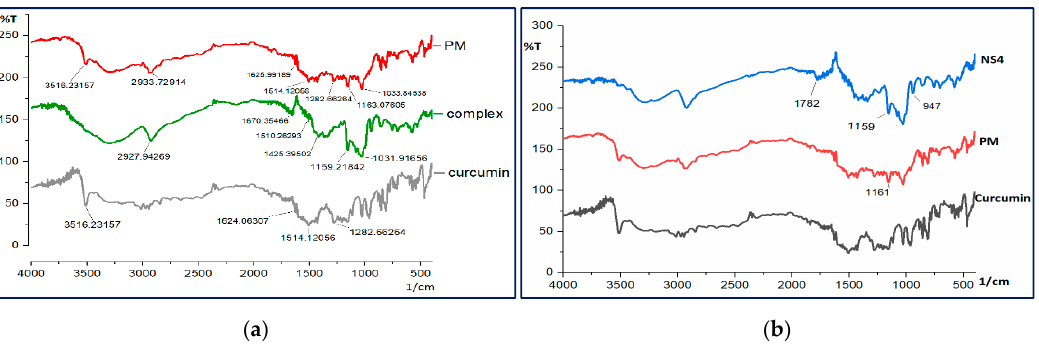
Figure 6. FTIR spectra of ( a ) curcumin- β -cyclodextrin complex; ( b ) curcumin-loaded nanosponge compared to the raw